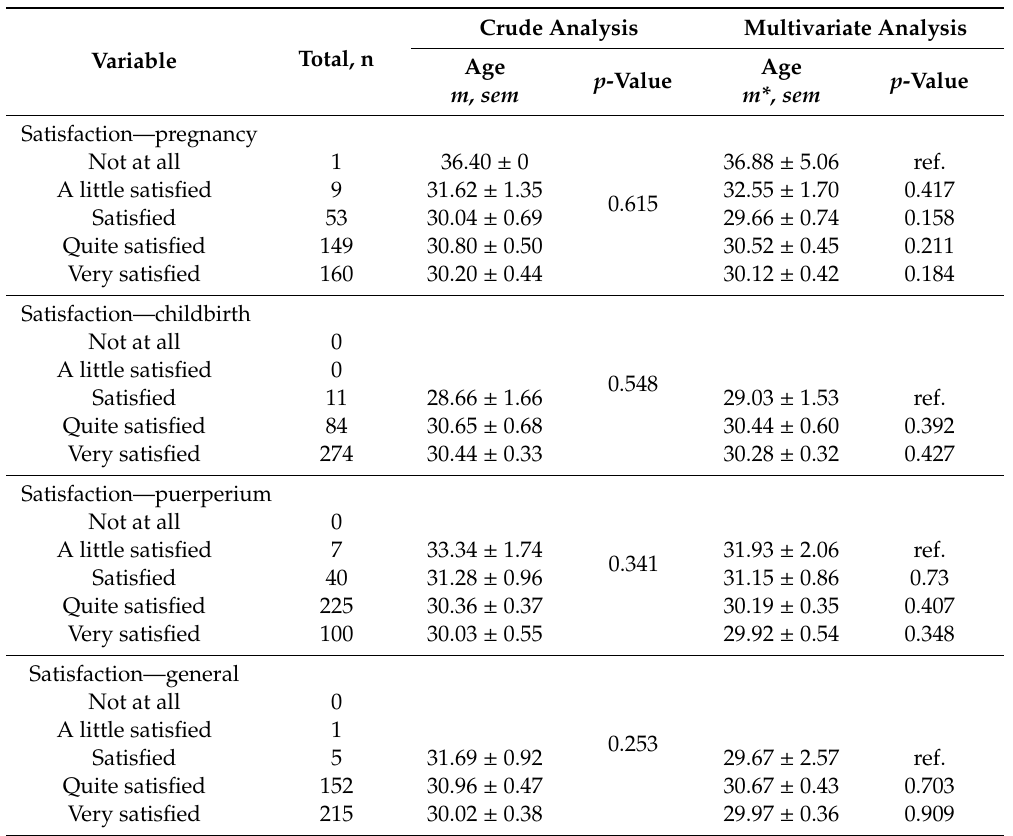
Table 2. Influence of maternal age on the woman’s satisfaction with the process of pregnancy, childbirth, and the